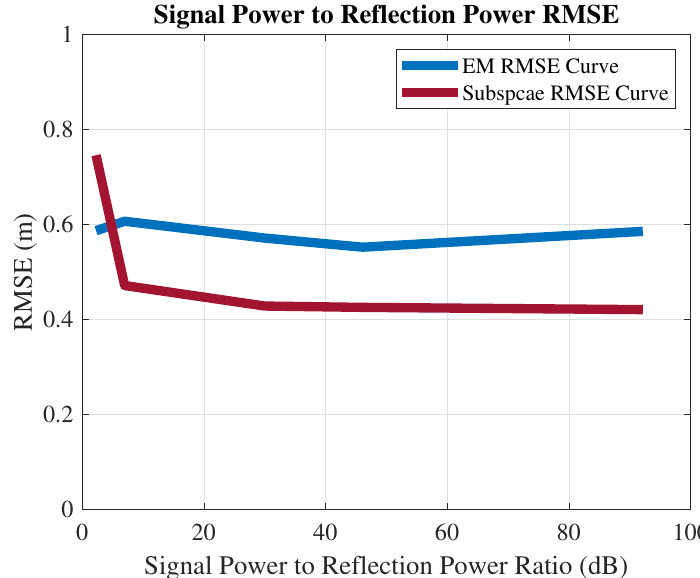
Figure 8. The impact of a nearby coherent source on the positioning